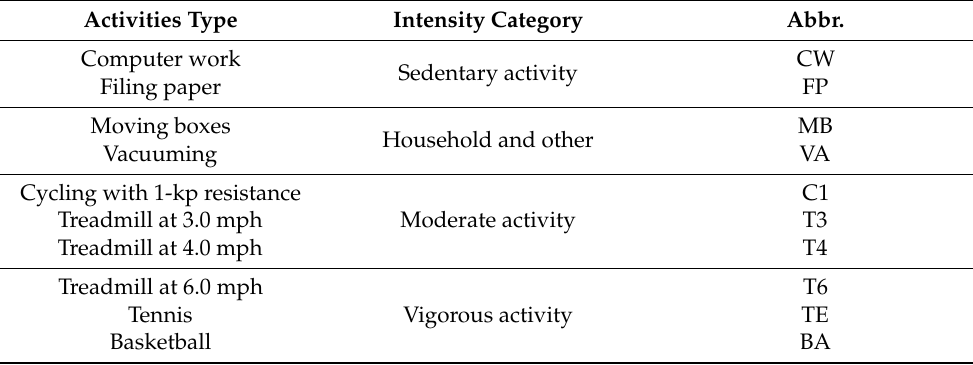
Table 2. Physical Activity types obtained for the